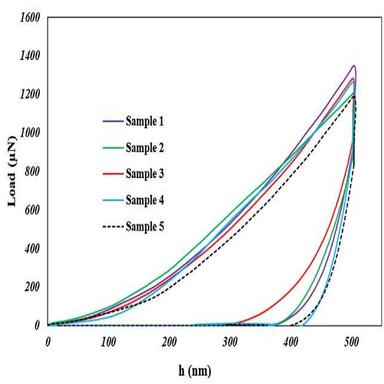
Load vs. displacement curves of individual RH biomasses as obtained from nanoindentation. The hysteresis provides information about the sample's hardness and modulus along with the indentation behaviour i.e. plastic or elastic. (For interpretation of the references to colour in this figure legend, the reader is referred to the web version of this article.)